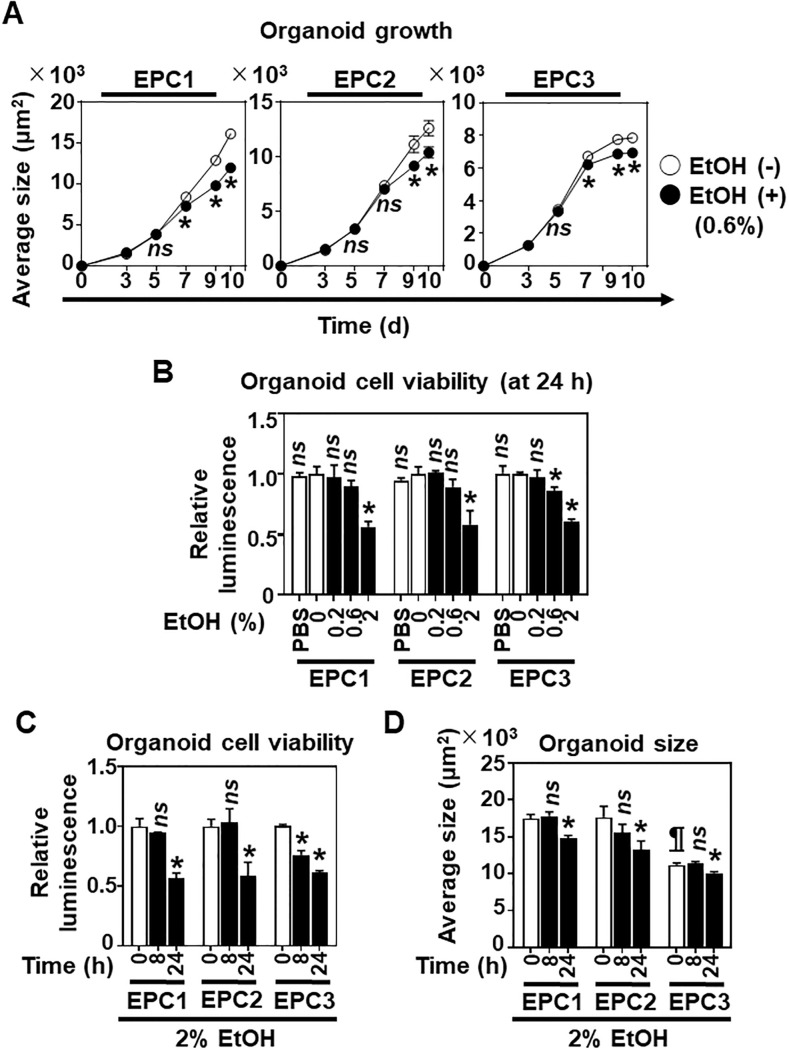
EtOH inhibits cell growth and viability in esophageal 3D organoids.Esophageal 3D organoids were generated from EPC1, EPC2 and EPC3 cells. A. 3D organoids were grown in the presence or absence of EtOH exposure (0.6%, 7 days from day 3 through day 10) in triplicate. Growth curve of 3D organoids was created by plotting average organoid sizes at the indicated time points. The size of individual organoids was determined as the area of each spherical structure in bright-field images (S1 Fig) captured by an automated microscope. At least 100 organoids were imaged per well at each time point. B-D. 3D organoids were first grown in the absence of EtOH for 9 days and then treated with or without EtOH. In B, organoids were treated in triplicate for 24 h with PBS (2%) or EtOH at indicated concentrations. PBS was used to assess the potential influence of medium dilution by EtOH. In C and D, 3D organoids were treated in triplicate with or without 2% EtOH for indicated time periods. In B and C, cell viability in 3D organoids was determined by CellTiter-Glo® assays. In D, average organoid size was determined as in A. Data represent mean ± sem. n = 3 per condition. *, p<0.05 vs. EtOH (-); ns, not significant vs. EtOH (-) at indicated time points in A. *, p<0.05 vs. PBS or 0% EtOH; ns, not significant vs. PBS or 0% EtOH in B. *, p<0.05 vs. 0 h; ns, not significant vs. 0 h in C. *, p<0.05 vs. 0 h; ns, not significant vs. 0 h; and ¶, p<0.05 vs. EPC1 or EPC2 at 0 h in D. Student’s t-test was used in A-D.